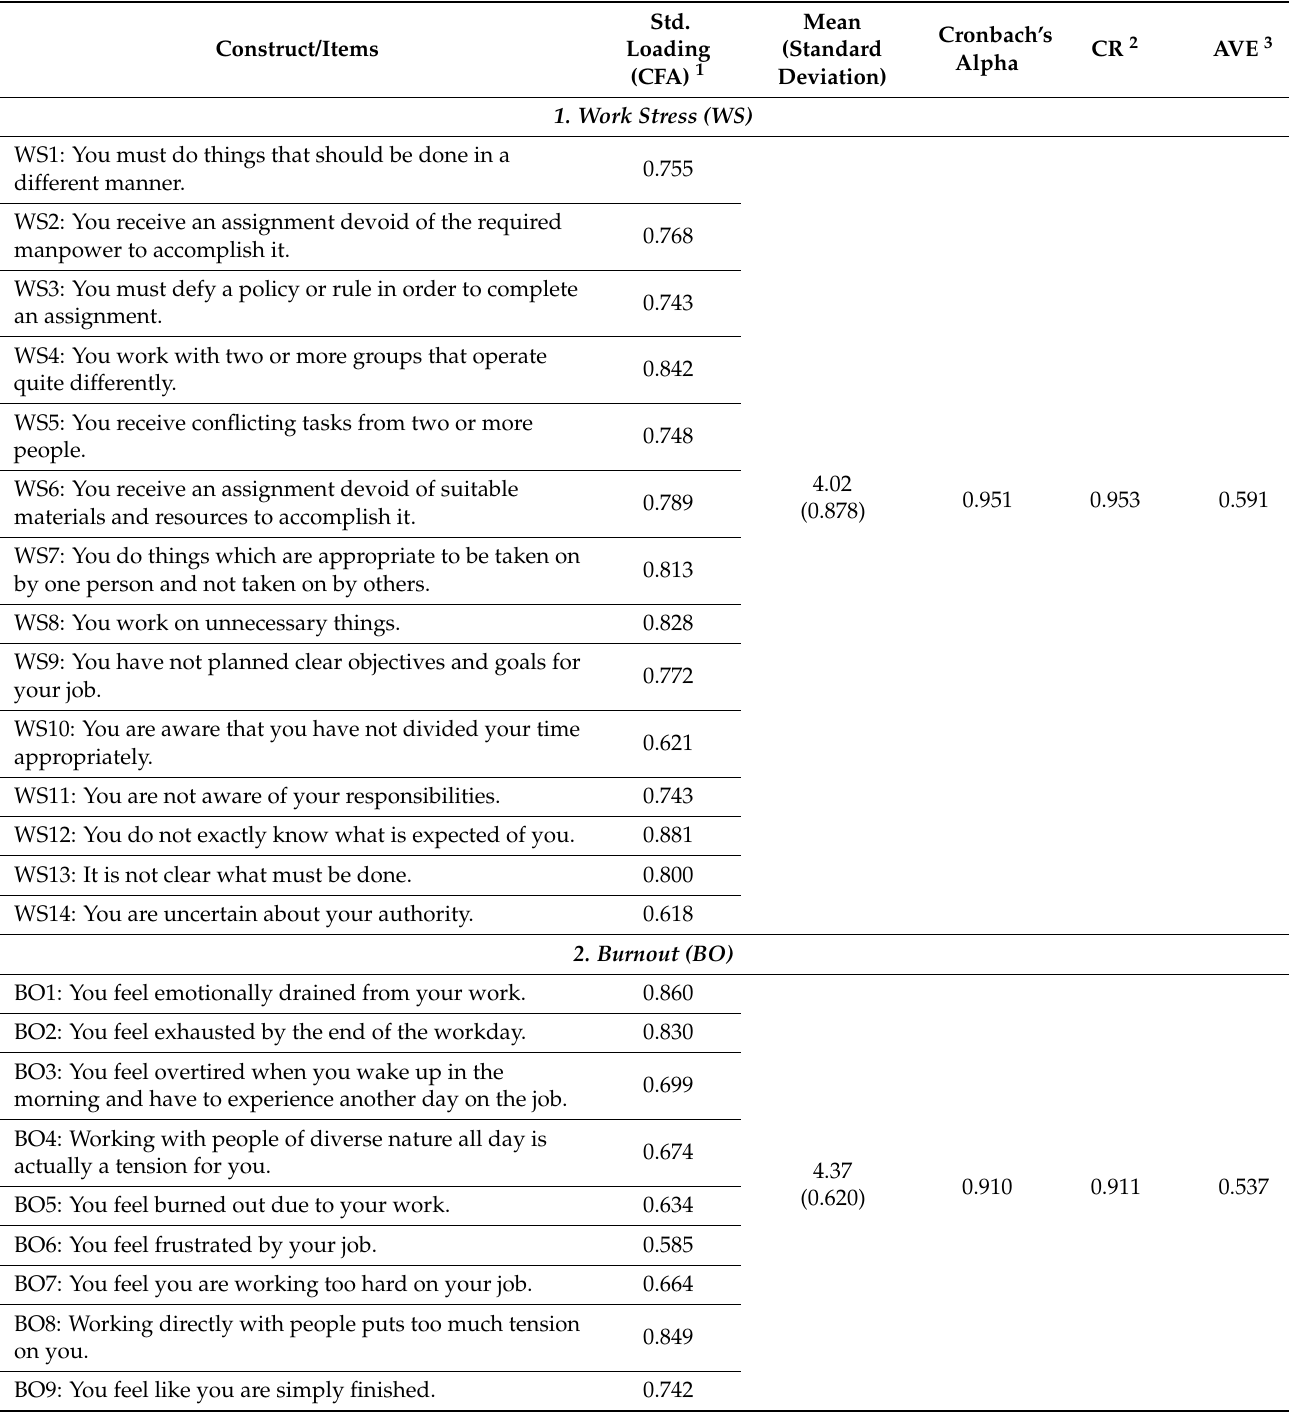
Table 1. Reliability and Confirmatory Factor Analysis Properties.